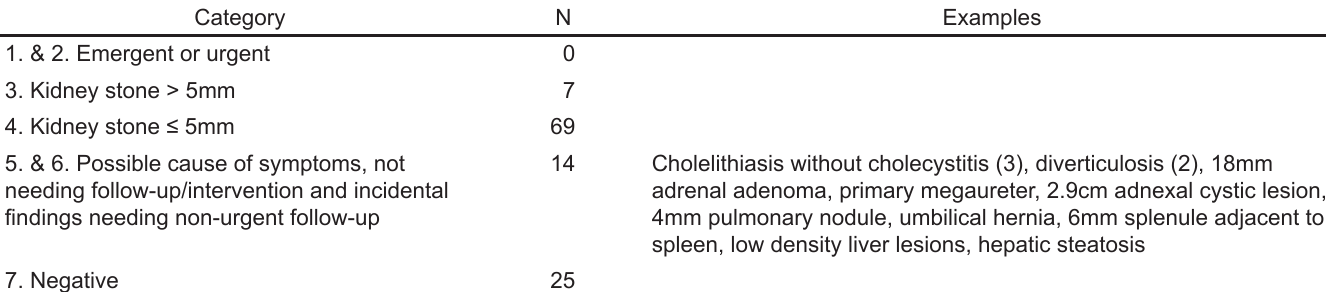
Table 2. Renal protocol computed tomography results by category (N =115).